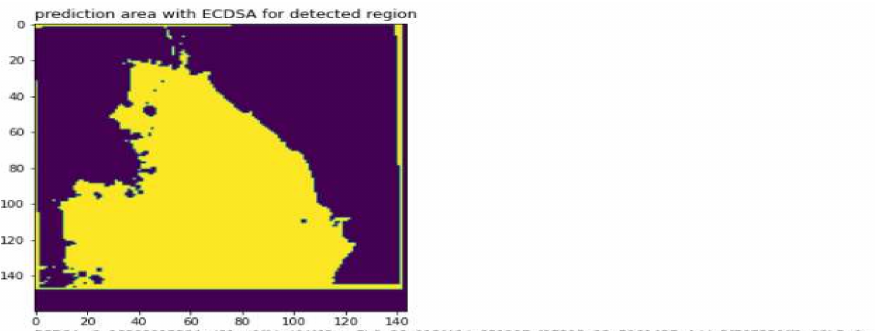
Figure 9. Predicted mask with ECDSA value—Case I.